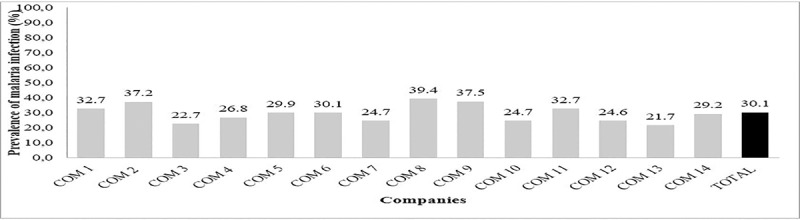
Prevalence of malaria infection with respect to company.